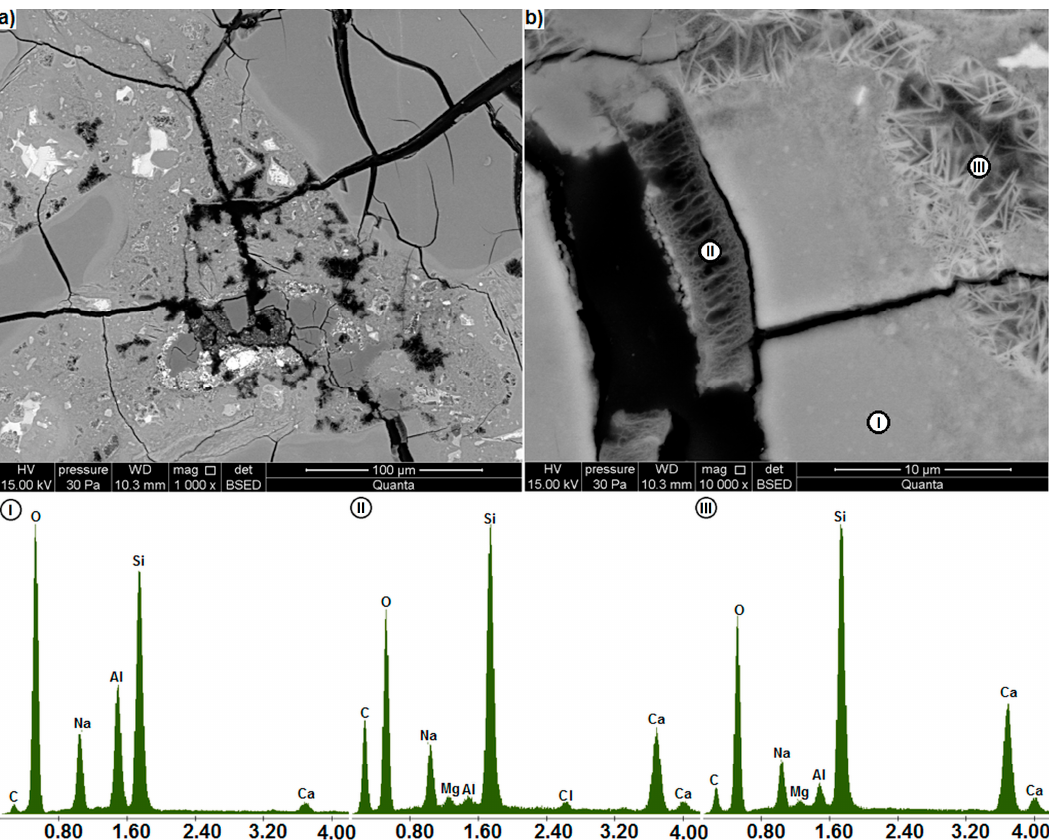
Figure 12. ( a ) extensively cracked area in the microstructure of the glass-containing mortar, ( b ) damage to waste glass particles (BSE); EDS analysis at points I, II and